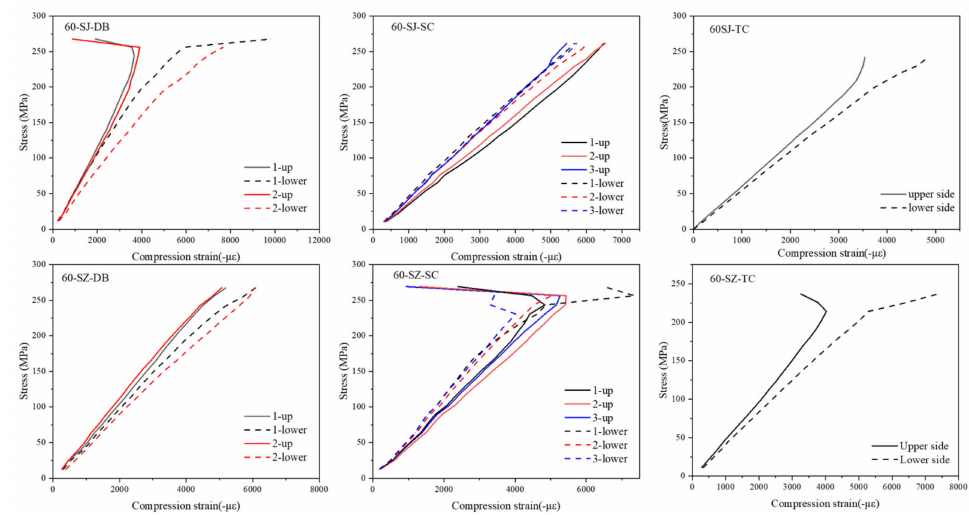
Figure 8. Stress–strain curves of specimens with particle density of 60 g/m 2